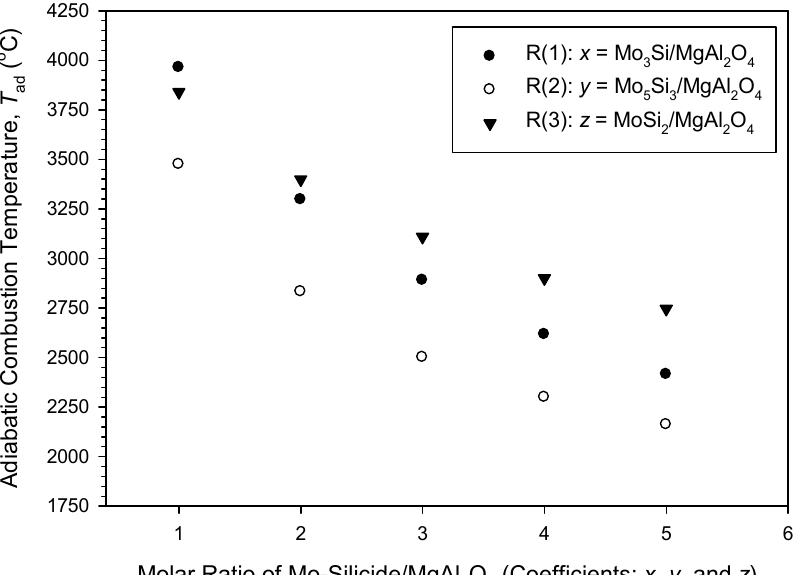
Figure 1. Variations of adiabatic combustion temperatures ( T ad ) with molar ratios of Mo-silicide/ MgAl 2 O 4 of products synthesized from R(1), R(2), and R(3).